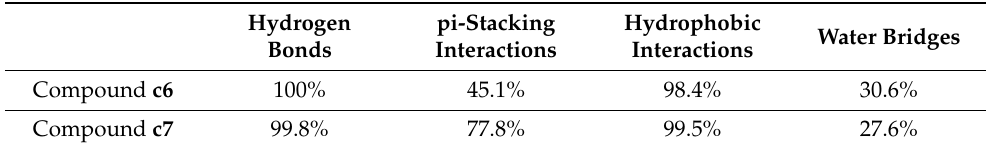
Figure 7. RMSF (root mean square fluctuation) of the core domain of hTop1p. In purple: RMSF Htop1p core domain in complex with compound 6 . In red: RMSF Htop1p core domain in complex with compound 7 . In green: RMSF Htop1p core domain. In evidence the root mean square fluctua- tion of the C α of the amino acids Arg364, Lys425, Tyr426, Met428 and Asp533, important in consti- Table 2. Ligand-receptor binding interactions per bond type over simulation time (1 µ s, conformation tuting the binding site of compounds c6 and c7 . sampling every 10 ps).